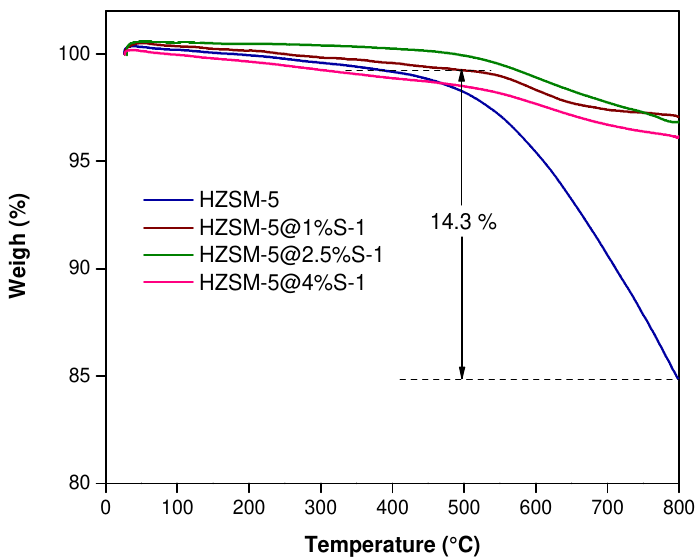
Figure 9. TGA curves of the parent HZSM-5 and HZSM-5@silicalite-1 catalysts after the toluene methanol methylation reaction for 20 h.